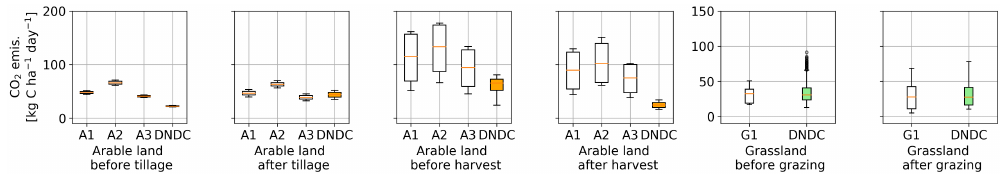
Figure 7. Management effects on CO 2 emissions. Measured and modelled emissions in a time window of 2 weeks before and 2 weeks after a